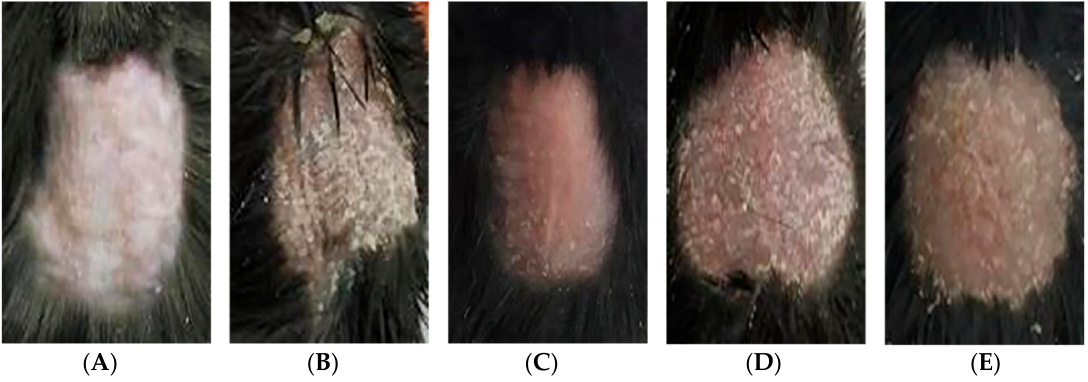
Figure 1. Morphological changes in skin lesions. ( A ) Control group. ( B ) Imiquimod (IMQ)-treated group. ( C ) Withanolides 500 mg/kg group. ( D ) Withanolides 250 mg/kg group. ( E ) Methotrexate ( MTX)-treated group.